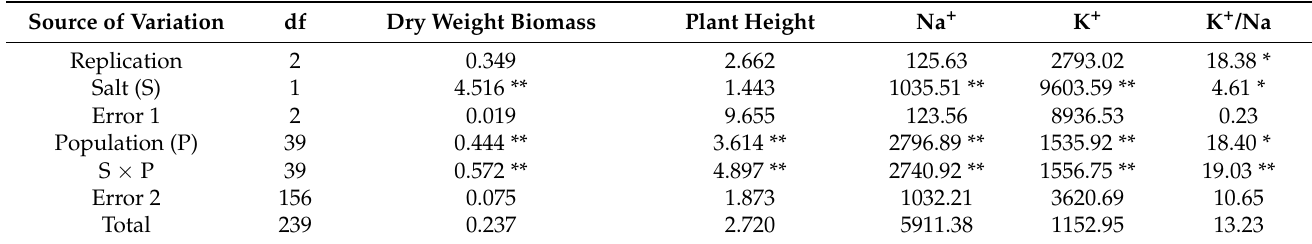
Table 1. Analysis of variance of dry weight biomass (g), plant height (cm), Na + , K + , and Na + /K + ratio under salinity and control conditions.